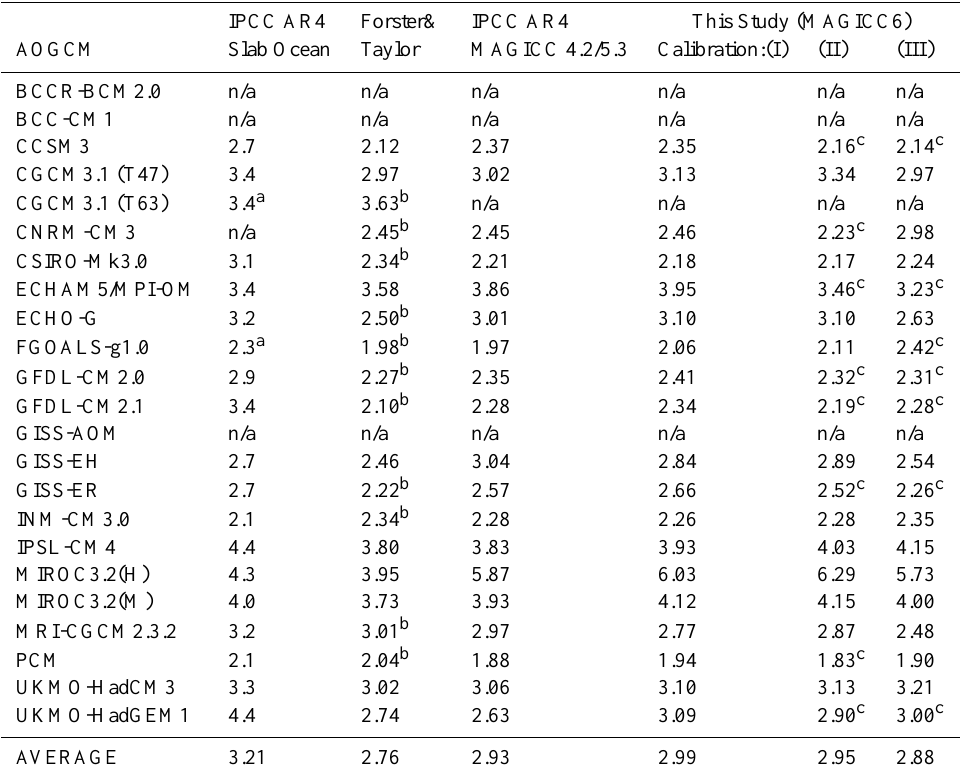
Table 4. Comparison of retrieved climate sensitivities for CMIP3 AOGCMs. The first column shows climate sensitivities estimated for the slab-ocean versions of the AOGCMs as given in Table 8.2 of Randall et al. (2007). The second column provides the climate sensitivities derived from the net climate feedbacks given by Forster and Taylor (2006), who use the method by Gregory et al. (2004) to retrieve feedbacks for idealized 1% CO 2 scenarios out to 2 × CO 2 . These climate feedbacks λ were converted to climate sensitivities 1T 2 × using 1T 2 × = 1Q 2 × with the forcing 1Q 2 × at doubled CO 2 concentrations taken from Table 2 in Forster and Taylor (2006), where available, and using 3.7Wm − 2 as default. The third column presents results for the MAGICC 4.2 calibration as done for IPCC AR4 , used as well in MAGICC5.3, and presented in Table S8.1 in Randall et al. (2007), which was methodological equivalent to the calibration method I presented here for MAGICC6. The fourth to sixth columns present this study’s results using MAGICC6 under calibration exercises I, II and III (see Table 1). The last row provides the average climate sensitivities for each